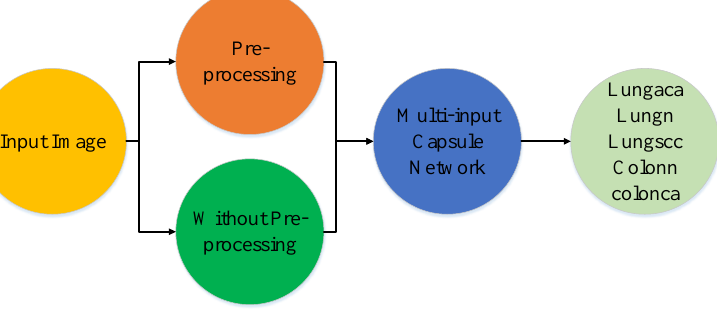
Figure 1. Diagram depicting the method in a very brief manner. lungaca: lung adenocarcinomas, lungscc: lung squamous cell carcinomas, lungn: lung benign, colonca: colon adenocarcinomas, and colonn: colon